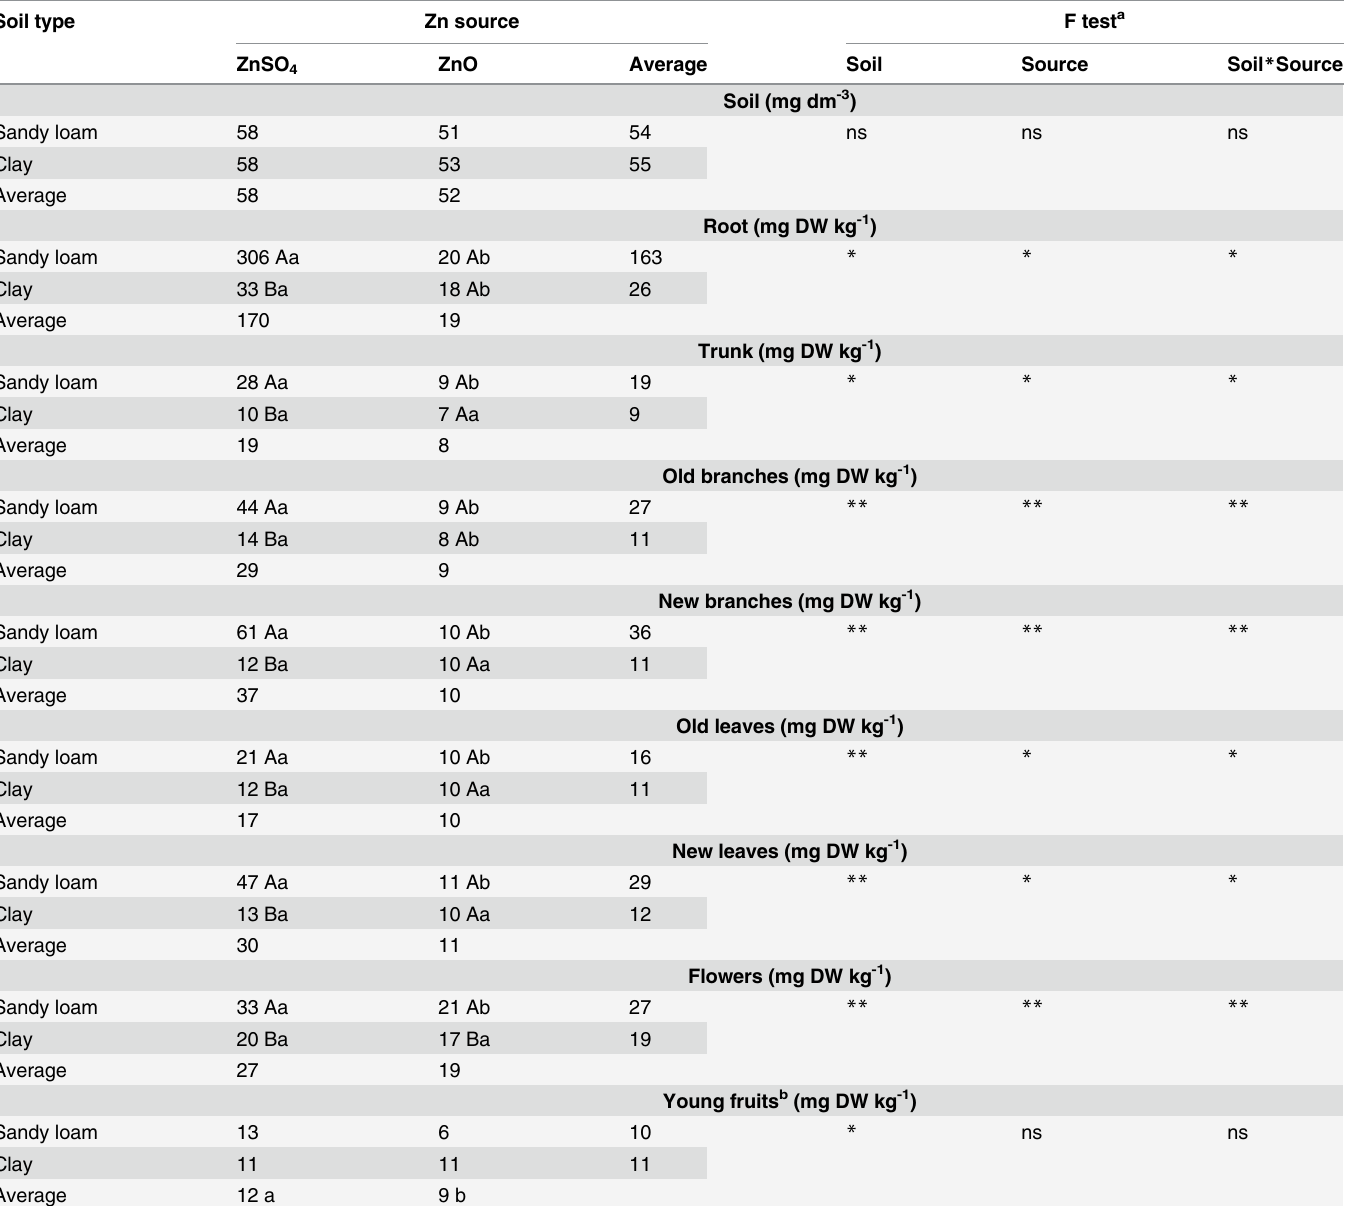
Table 3. Concentration of Zn in the soil and plant parts of young orange trees 150 days after ZnSO 4 or ZnO application in soils with sandy loam or clay